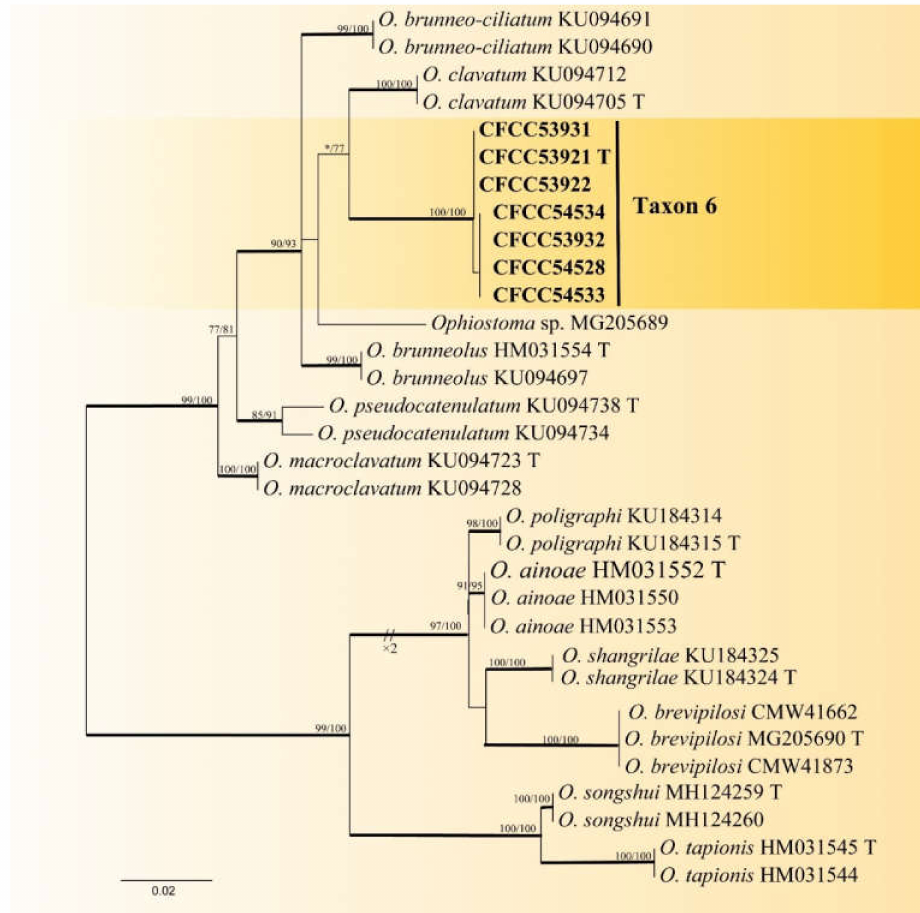
Figure 7. ML tree of O. clavatum complex (Taxon 6) generated from the combined (ITS + TUB2) sequence data. Novel sequences obtained in this study are presented in bold typeface. Bold branches indicate posterior probability values ≥ 0.9. Bootstrap values ≥ 70% for ML and MP are indicated above branches. Bootstrap values < 70% are indicated by *. Strains representing ex-type sequences are marked with